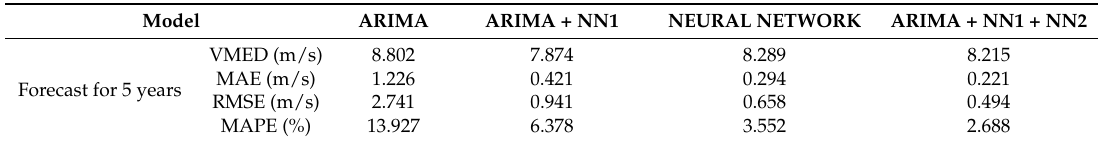
Table 8. Error results for multi-steps long term forecast (years).